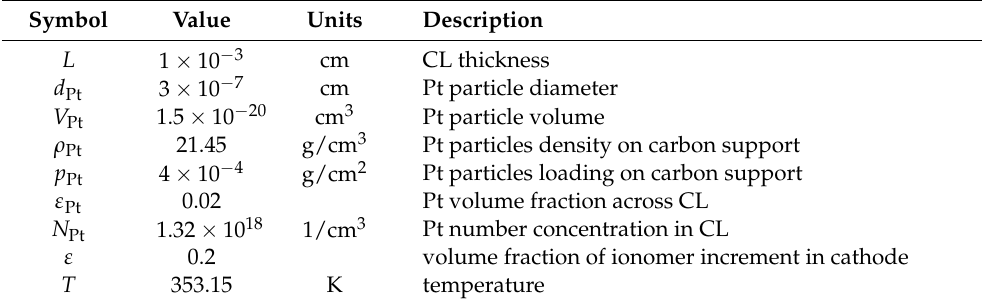
Table 1. Parameters for cathode catalyst